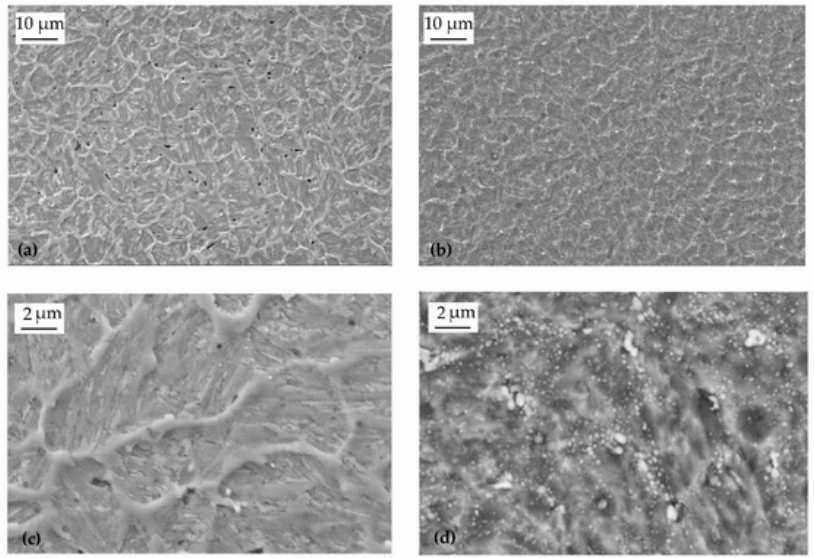
Figure 9. Scanning electron microscope (SEM) micrographs of the microstructure of samples obtained through ESF on the YZ plane. ( a , c ) Sample C in the as-ESFed condition and ( b , d ) sample D in the Q + T